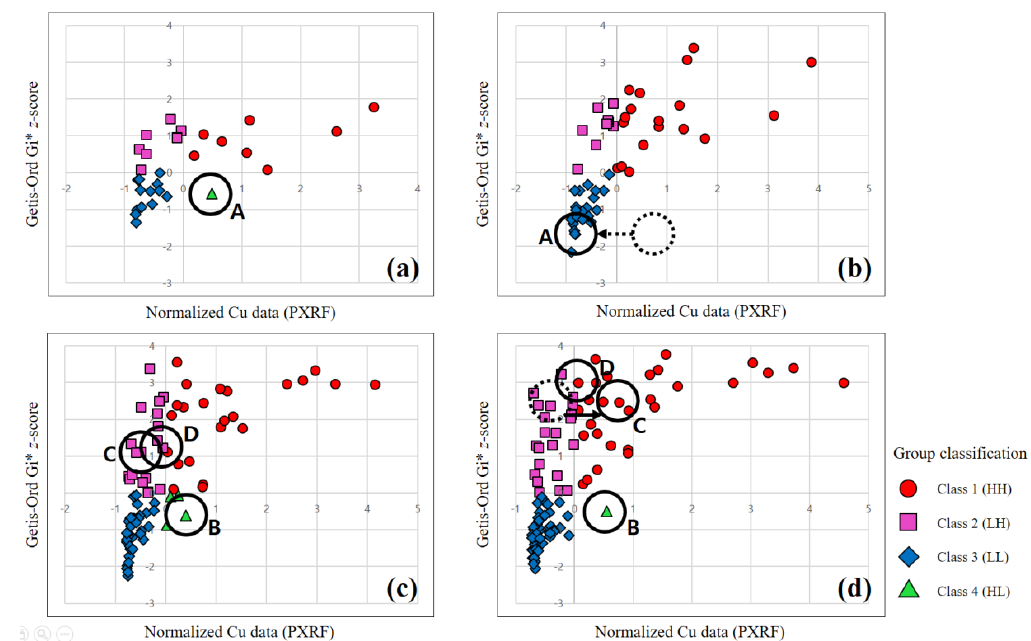
Figure 7. Group classification according to the copper concentration and Gi* z -score for each phase: ( a – d ) Phases 1–4, respectively. Samples A and B were estimated to be erroneous and a re-investigation was conducted for those sampling points. Int. J. Environ. Res. Public Health 2017 , 14 , 654